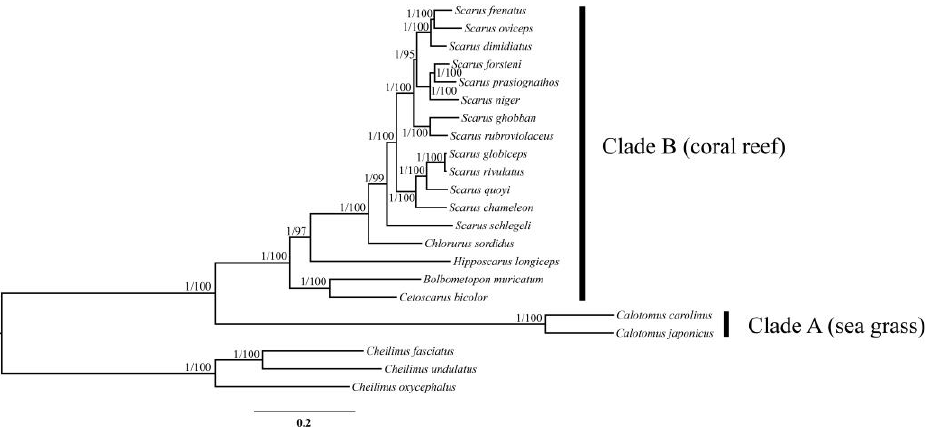
Figure 8. Phylogenetic relationships of the parrotfishes based on 13 PCGs and 2 rRNAs using Bayesian inference (BI) and maximum likelihood (ML). Numbers at nodes indicate Bayesian posterior probabilities (PP) and ultrafast bootstrap supports (UFBoot) from maximum likelihood analysis, respectively. Only well-supported numbers (PP > 0.95, UFBoot > 95) are shown.